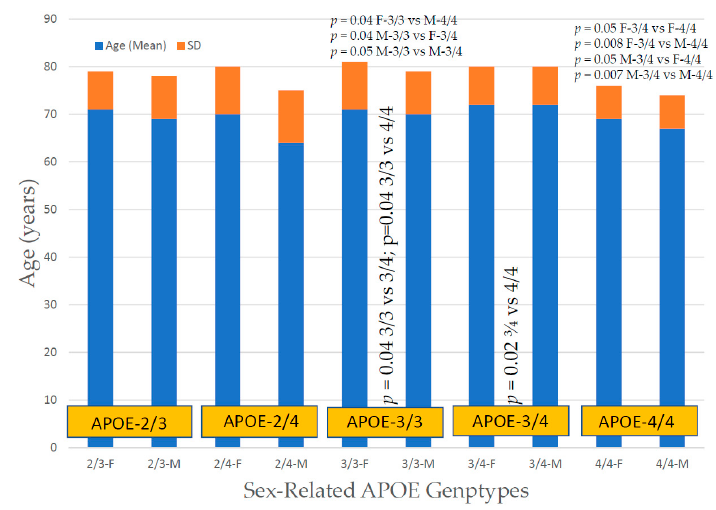
Figure 7. APOE -related differences of age at onset in Alzheimer’s disease.